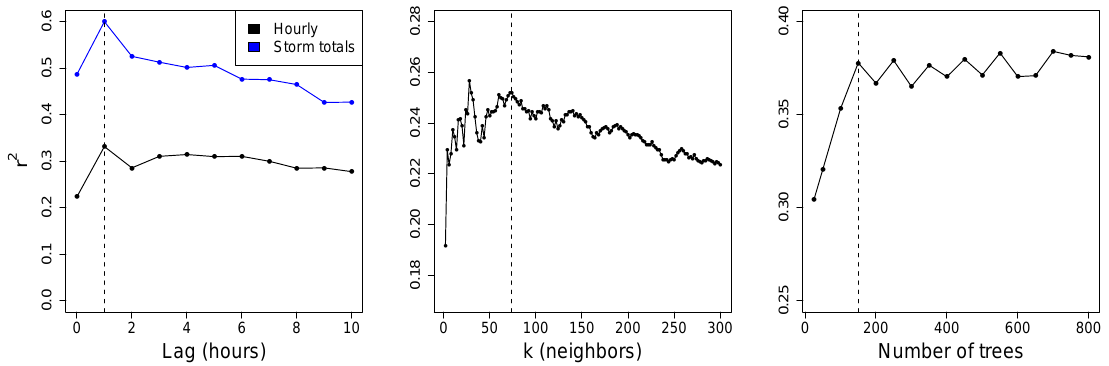
Figure 3. Mean LOSO cross-validated squared correlation between actual and predicted outages using Poisson regression on feature sets with varying lags ( left ), KNN at settings of k ∈ { 2,4,6, . . . ,300 } ( middle ); random forest at several settings of the number of trees ( right ). Selected values are marked by vertical dashed